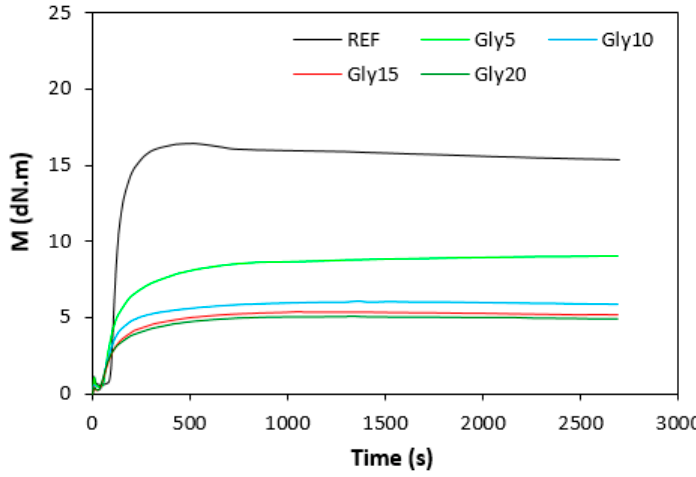
Figure 2. Vulcanization isotherms for rubber compounds based on NBR.